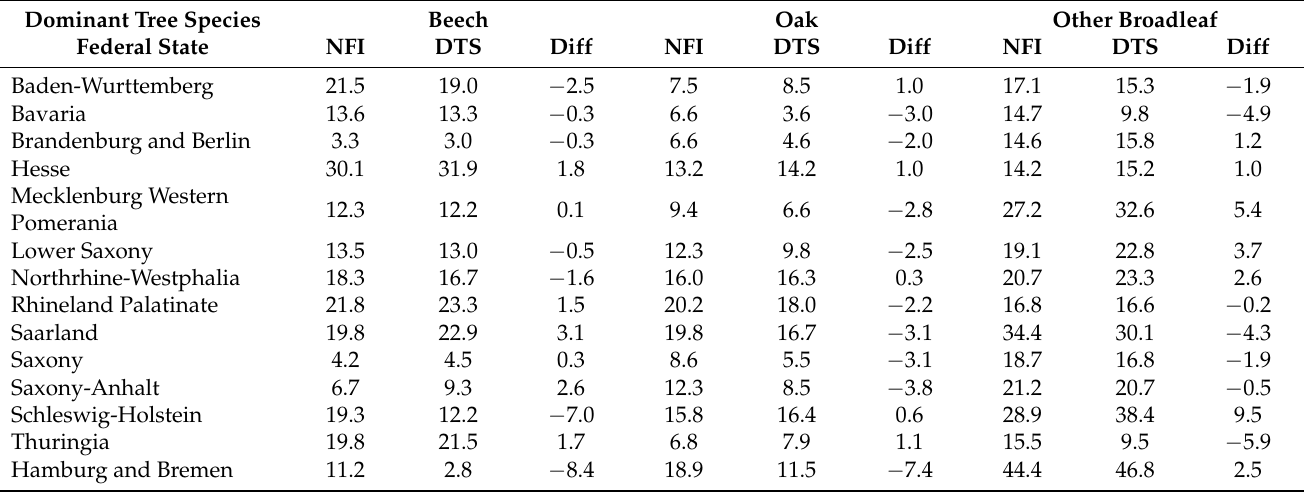
Table 3. Percentage of area covered by each tree species in the forest area per federal state. Comparison of NFI data and the classification (DTS). Diff shows the difference in percentages for deciduous trees.